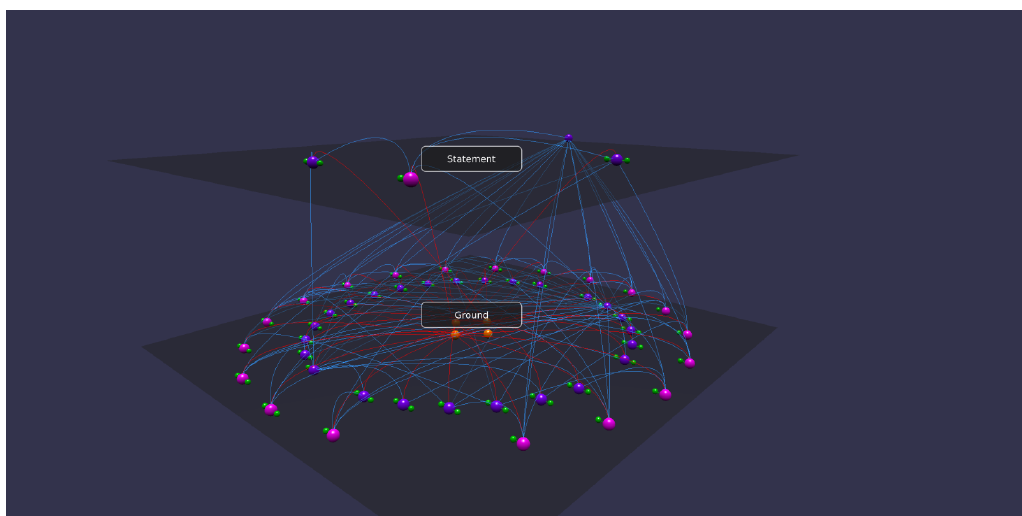
Figure 15. Use Case #3: A statement has been moved to a dedicated